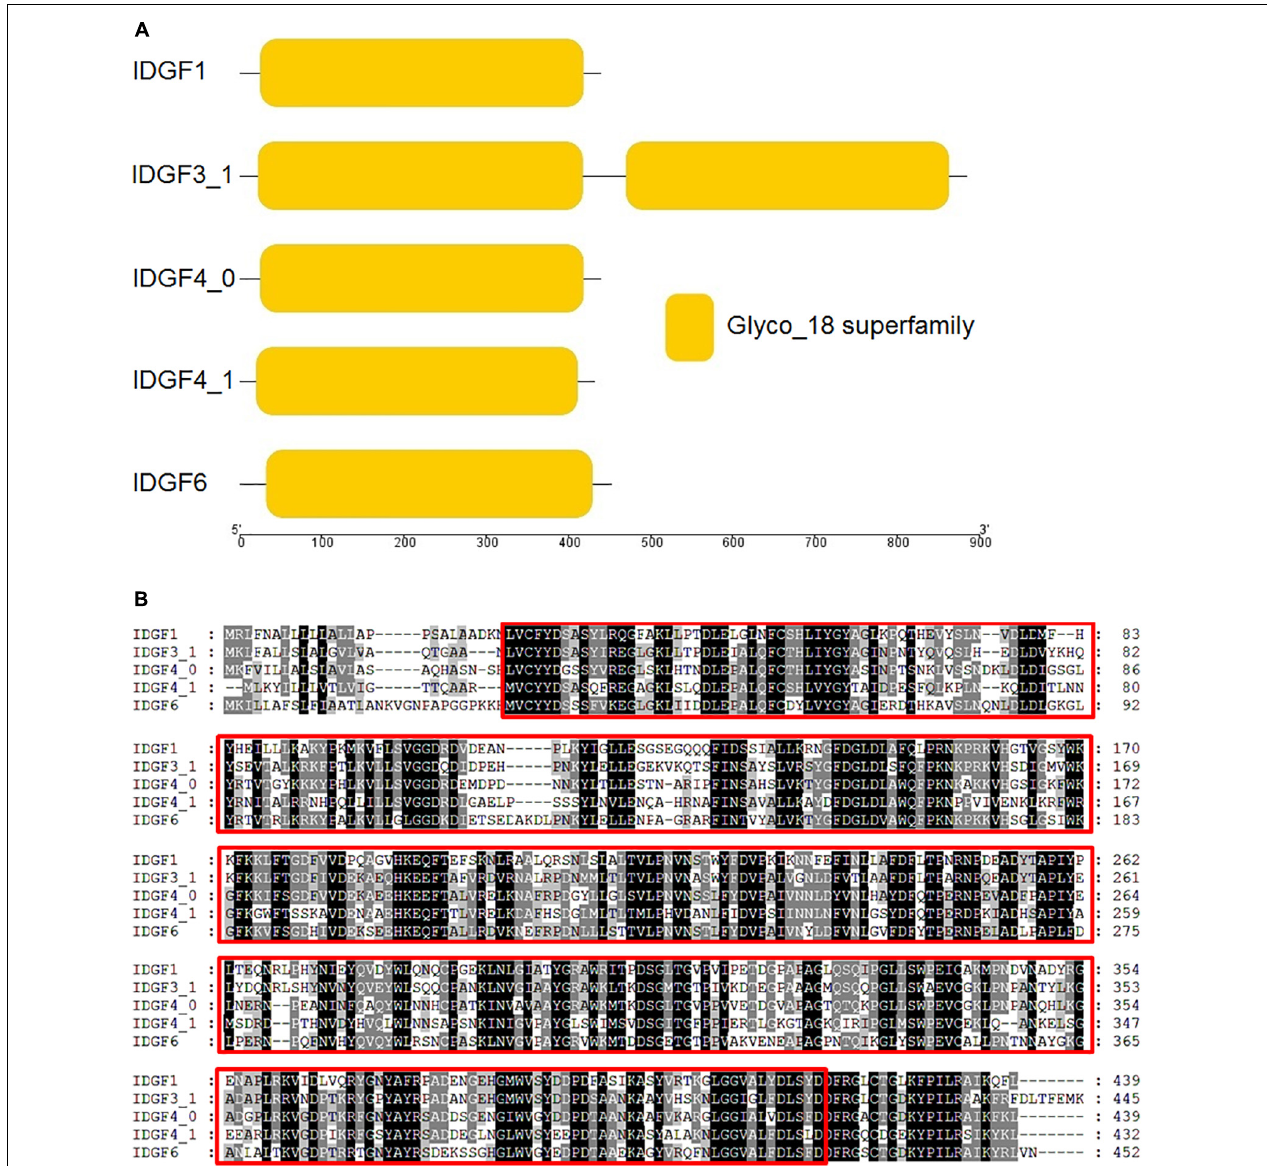
FIGURE 2 | (A) Imaginal disc growth factors gene, also their domain architecture and motif in Z. cucurbitae. The deduced amino acid sequences were used to predict the domain architectures of the five IDGFs genes using online conserved domain database (CDD) and presented through TBTool software. (B) Amino acid sequence alignment of IDGFs was performed using ClustalW alignment method in MEGA7. In GeneDoc program, ClustalW alignment was used to shade the identical and similar amino acids in the alignment. The conserved regions among five IDGFs sequences are tinted with red box. Dark shade indicates identical amino acids and gray shade represents similar amino